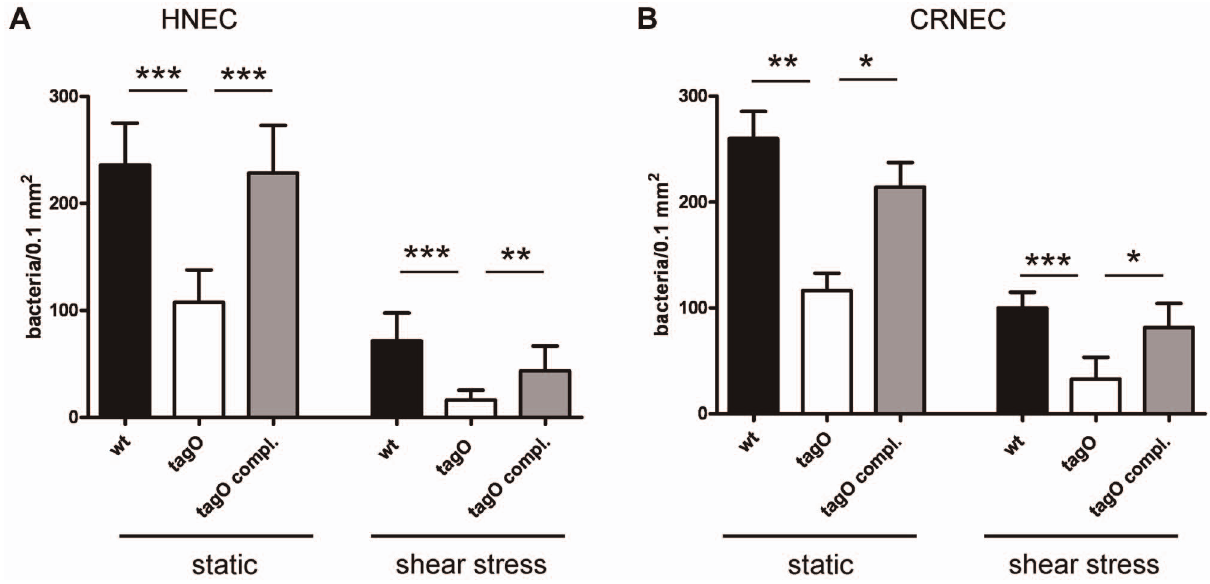
Figure 3. WTA-mediated adhesion of S.aureus to HNECs and CRNECs. S. aureus adherence to confluent human nasal epithelial cells (HNECs) monitored under static and mild shear stress condition (0.5 dynes) in 24 well plates or flow chamber assays, respectively. Attachment of the S. aureus wild-type (wt), tagO , and a complemented tagO mutant ( tagO compl.) evaluated microscopically by counting at least 6 visible fields per well or chamber slide containing HNECs (A) or CRNECs (B). The data is expressed as means and SEM of 5 independent experiments (static) or of 6 independent experiments (flow). Statistical analysis was performed by one-way ANOVA with Bonferroni’s multiple comparison test. Significant differences between groups are indicated by one ( P , 0.05), two ( P , 0.01), or three ( P , 0.001) asterisks ( *